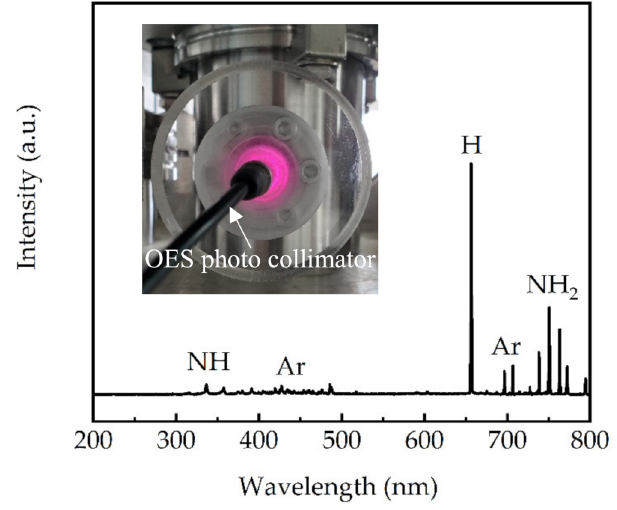
Figure 1. OES measurement and spectrum of the NH 3 +Ar plasma at 2500